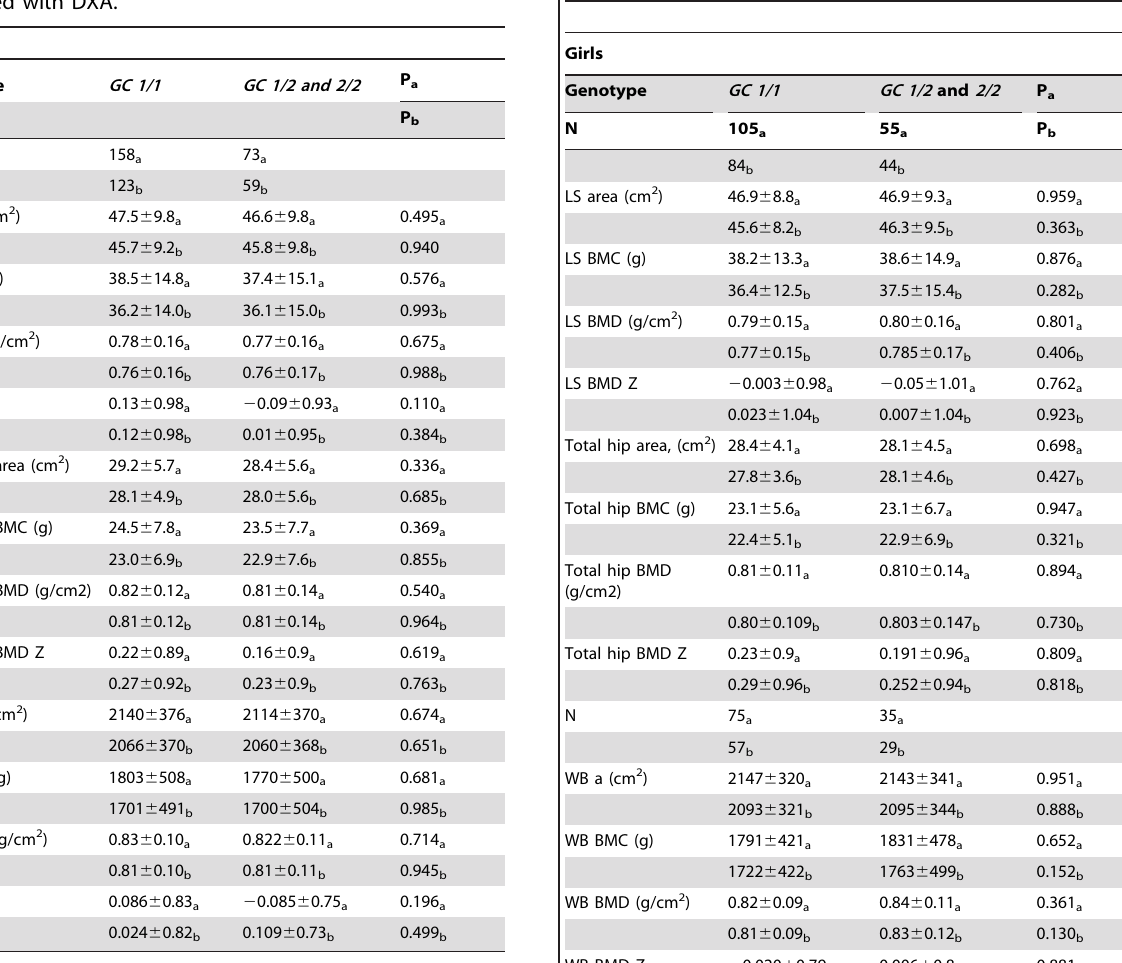
Table 3. Bone variables for genotype 1/1 and genotypes Gc 1/2 and 2/2 combined in girls measured with